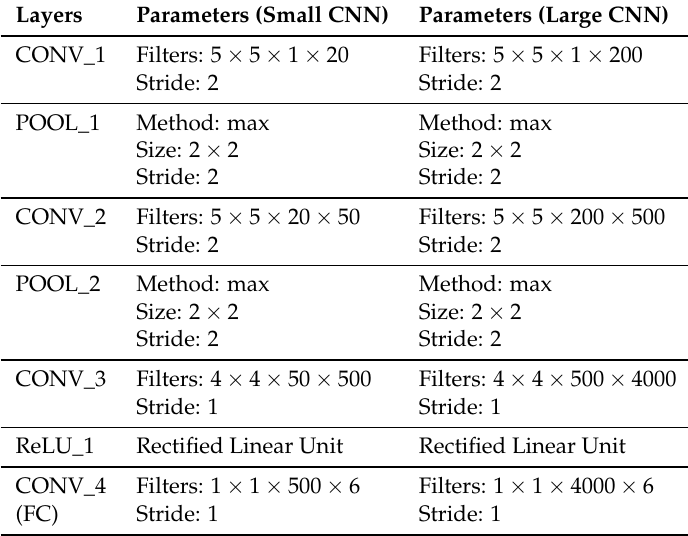
Table 1. Description of the adopted CNN